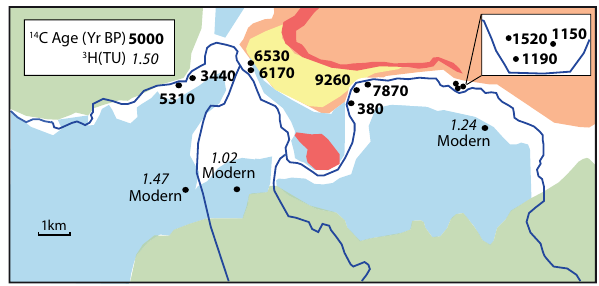
Figure 7. Groundwater residence times within the Gellibrand Val- ley. Residence times up to 9260 years are found in close proximity to the river. Modern local groundwaters with a 14 C > 100pMC are situated back on the floodplain. Data from Tables 1 and